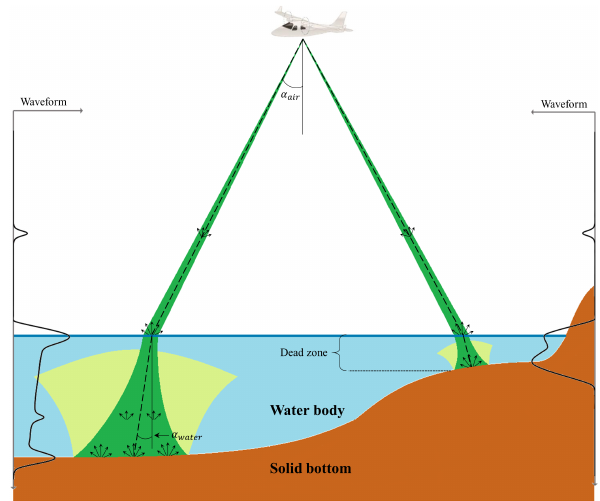
Figure 2. Conceptual sketch of the laser beam propagation and re- turn signals. The beam refracts upon entering the water body, and it diverges as it propagates through the water column. Return signals are produced in the air, at the water surface, in the water column and at the seabed. The lidar instrument has limited capability in very shallow water (the dead zone in the figure) because the successive peaks from the water surface and the seabed are not individually separated in time and amplitude. Only the largest peak, which is from the seabed, is